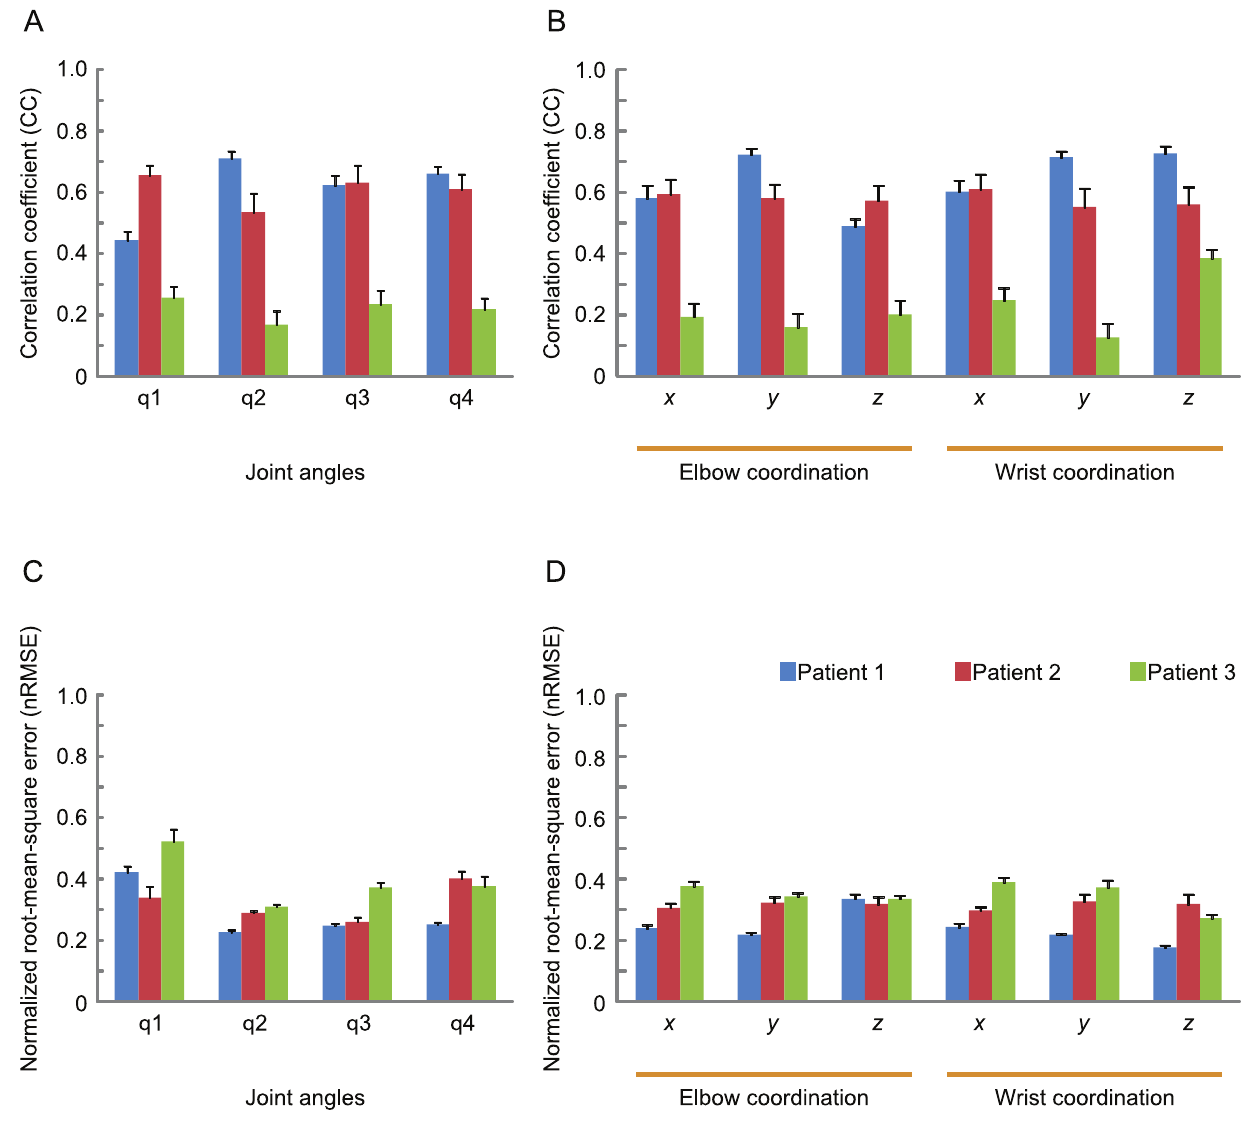
Figure 7. Prediction results for all patients. Averaged correlation coefficients (CC) for joint angle (A) and x , y , z coordination (B), and the normalized root-mean-square error (nRMSE) for joint angles (C) and x , y , z coordination (D) were obtained using LOO-CV on 20, 19 and 73 trials for patients 1, 2, and 3 (blue, red, and green bars), respectively.